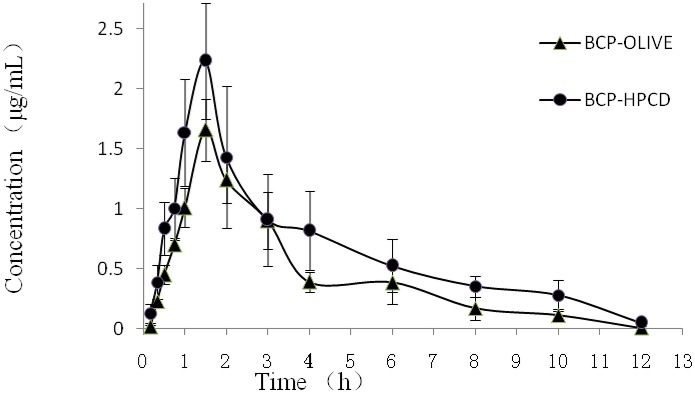
Mean (±S.D.) plasma concentration–time profiles of BCP-OLIVE and HPβCD/BCP by intraperitoneal injection at a dose of 50 mg/kg (n = 5). The plasma content of BCP administered with HPβCD/BCP was higher at all time points in comparison to that obtained after administered with BCP-OLIVE.